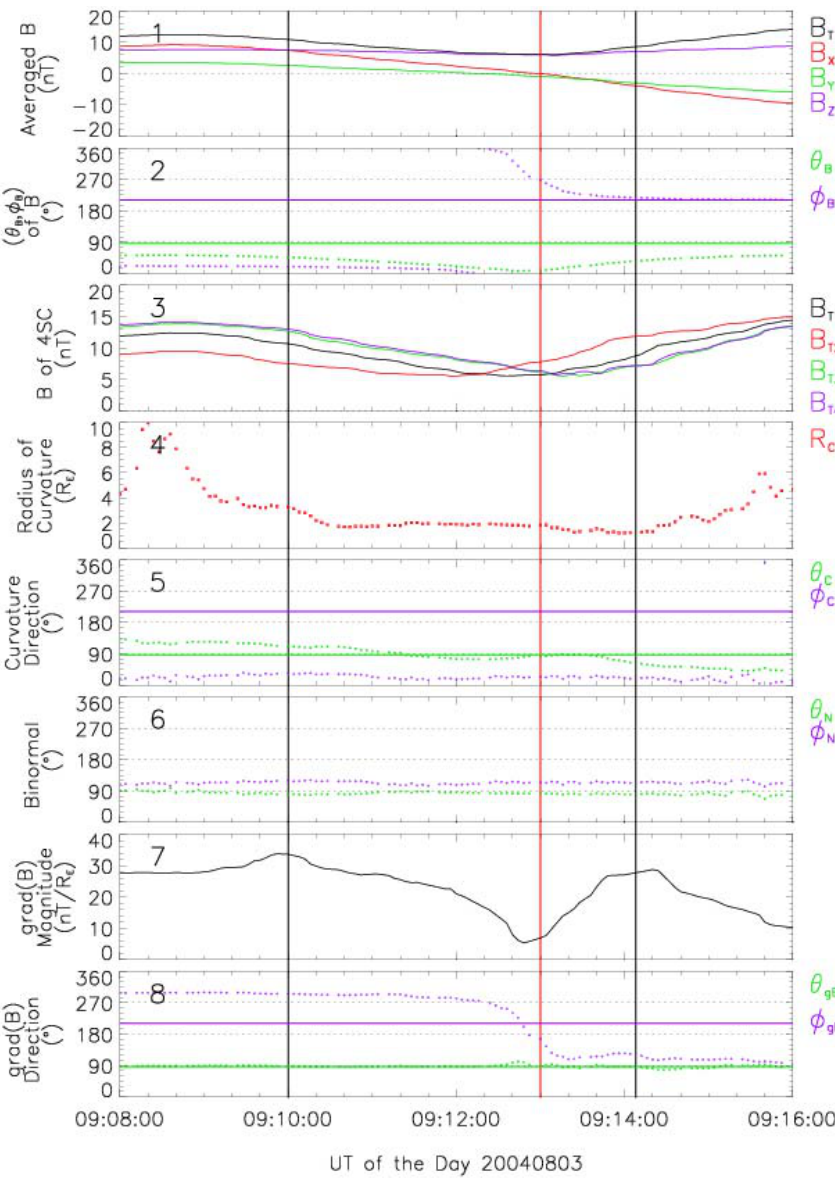
Fig. 3a. The geometric structure of the tilted current sheet during one Cluster crossing event on 3 August 2004. The format of the figure is the same as Fig. 1a.